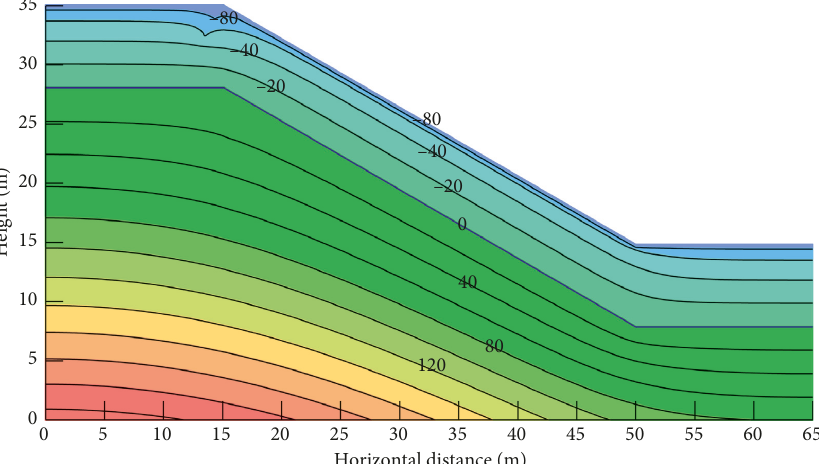
Figure 3: Initial pore water pressure distribution in slope (unit: kPa).